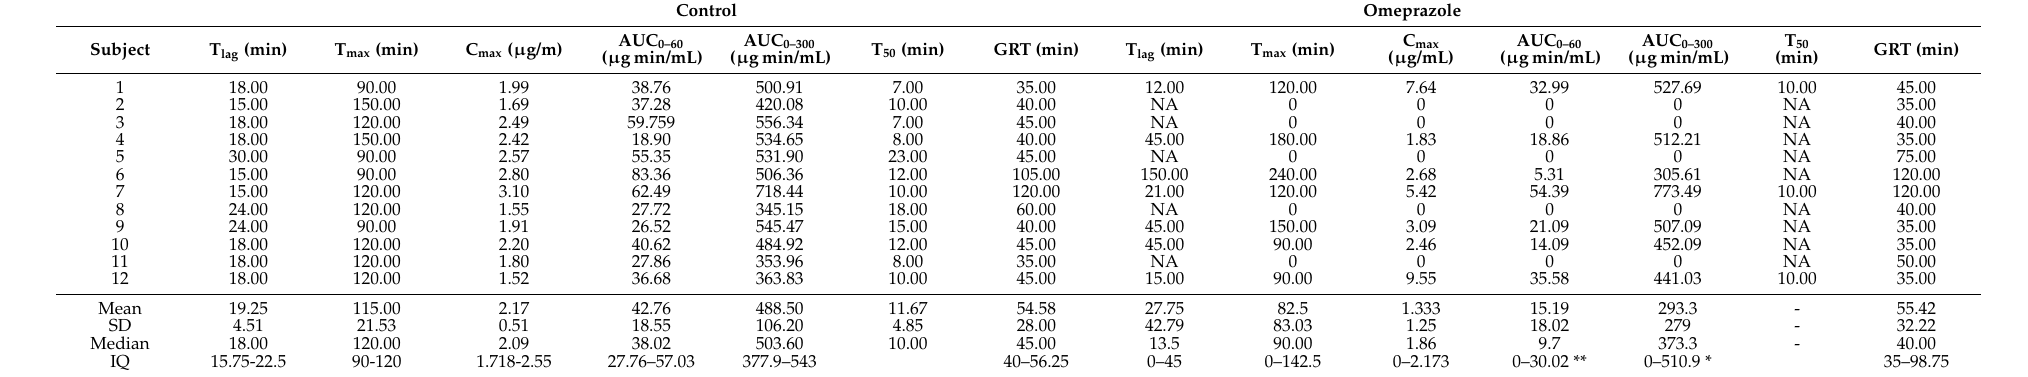
Table 3. Comparison of pharmacokinetic parameters before (control) and after omeprazole administration to healthy volunteers. Data are expressed as the mean ± SD and median. NA= not available * p < 0.05 vs. control; ** p <